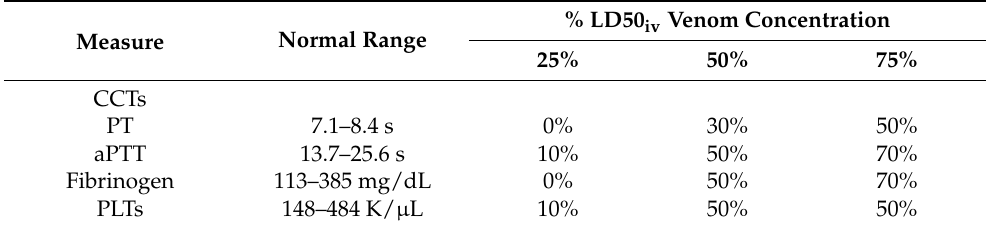
Table 1. Sensitivity of classical coagulation tests and TEG parameters: percentages of samples beyond normal reference